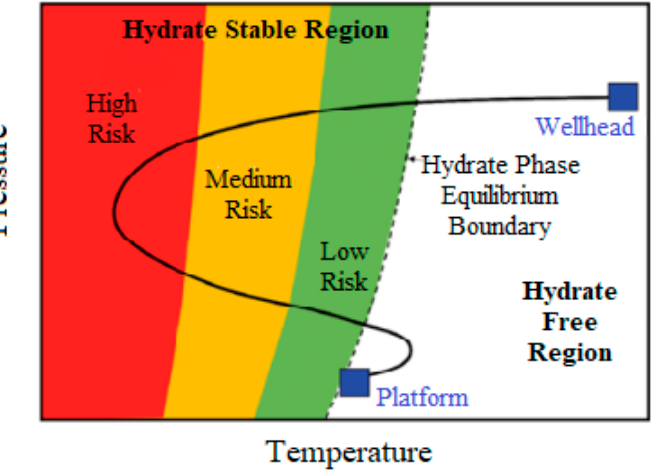
Figure 5. Illustration of a risk map for hydrate formation in oil and gas production Reproduced with permission from Ref [36] Copyright 2017 Springer Nature.